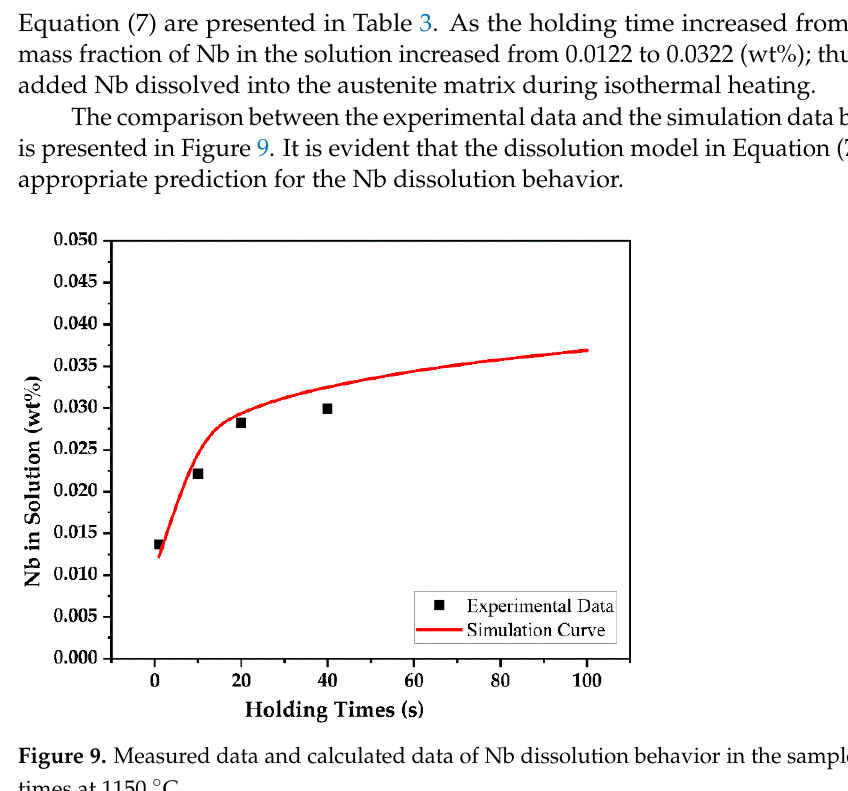
Table 3. Volume fraction of precipitates and the calculated values of Nb content in the solution at various isothermal times.